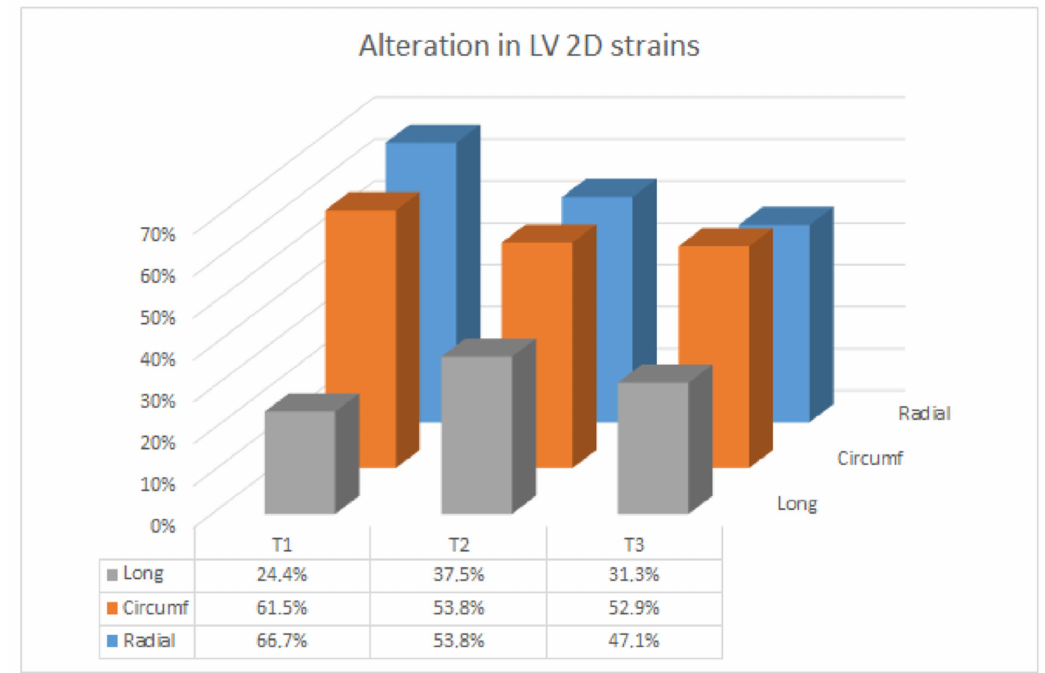
Figure 2. Left ventricular 2D strain alterations in the whole